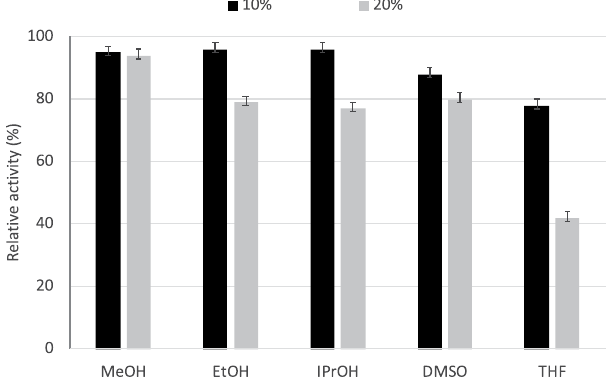
Figure 2. Stability of Vb TA T16F after storage for 2 days at 25 °C, in the presence of different solvents. Data are reported as relative percentage activity, in comparison with the control in standard conditions. Results are reported as the average of triplicate